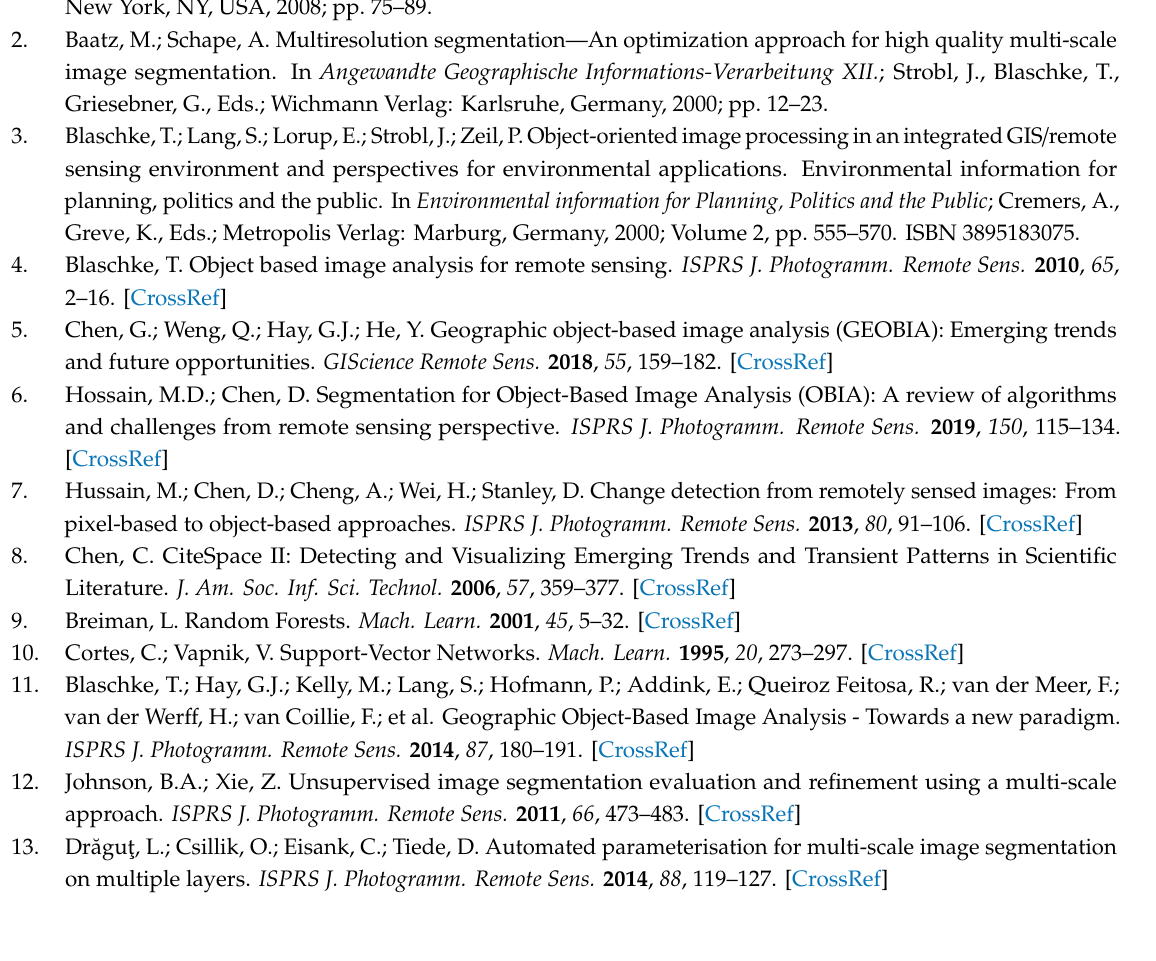
Table S1: Responses to online questionnaire survey on